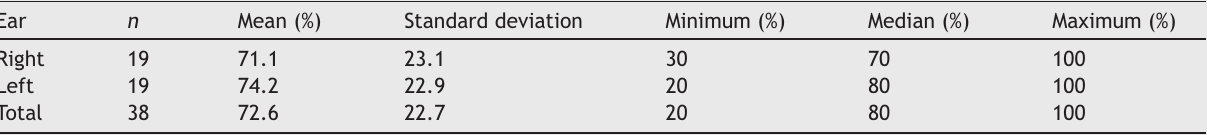
Table 2 Descriptive statistics values for the percentages of correct answers in the speech test with white noise and pictures according to the right and left